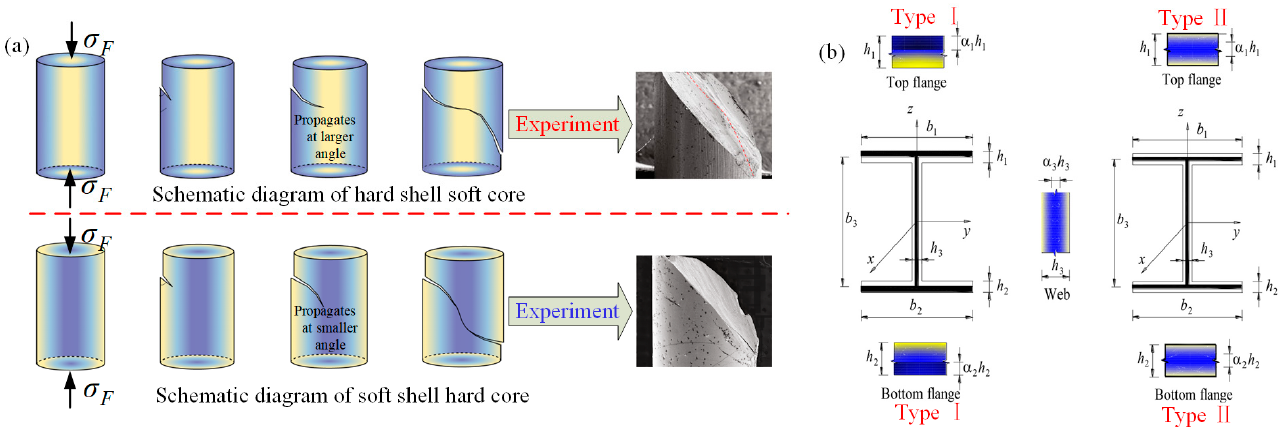
Figure 6. Deformation instability mechanism of functionally gradient metal materials: ( a ) shear instability and actual fracture morphology of hard-shelled soft-core and soft-shelled hard-core materials [88]; ( b ) schematic diagram of two types of sandwich I-beams [89].